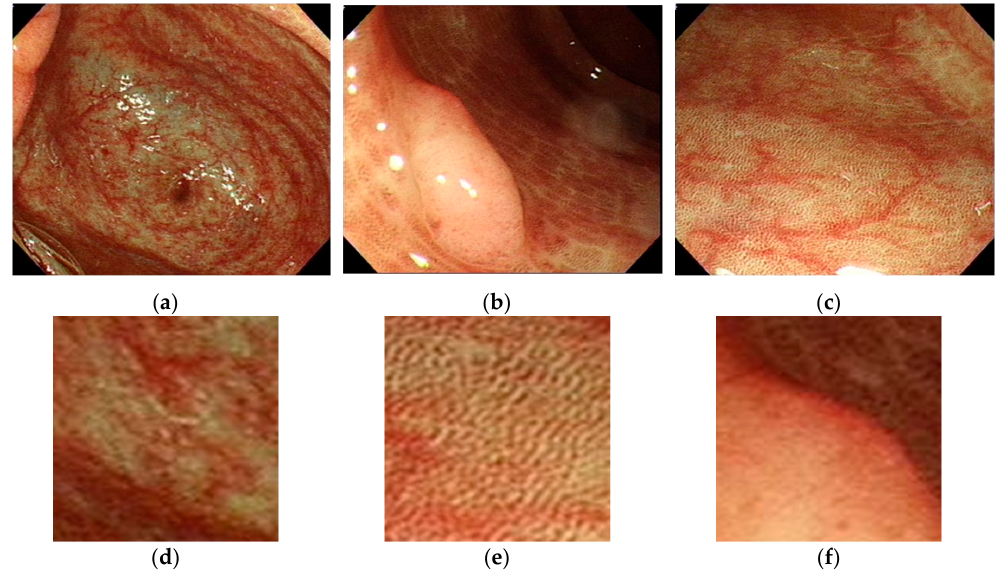
Figure 2. Images extracted from one patient with melanosis coli ( a ) cecum, ( b ) splenic flexure, and ( c ) colon polyp. The regions of interest ( d ) cecum—from ( a ); ( e ) splenic flexure—from ( b ); ( f ) colon polyp—from ( c ).